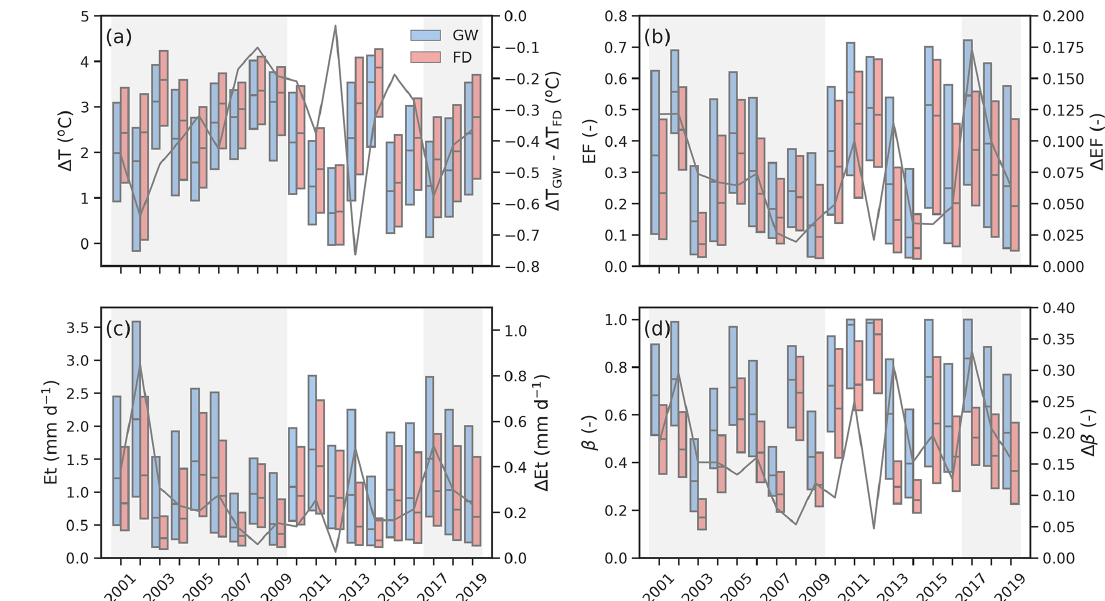
Figure 3. Groundwater-induced differences in (a) T canopy − T air ( (cid:49)T ), (b) evaporative fraction (EF), (c) transpiration ( E t ), and (d) water stress factor ( β ) during 2000–2019 summer heatwaves over forested areas (the green region in Fig. S2a). The left y axis is the scale for boxes. The blue boxes refer to the GW experiment and the red boxes to FD. For each box, the middle line is the median, the upper border is the 75th percentile, and the lower border is 25th percentile. The right y axis is the scale for the grey lines which display the difference in the medians (GW–FD). The shadings highlight the two drought